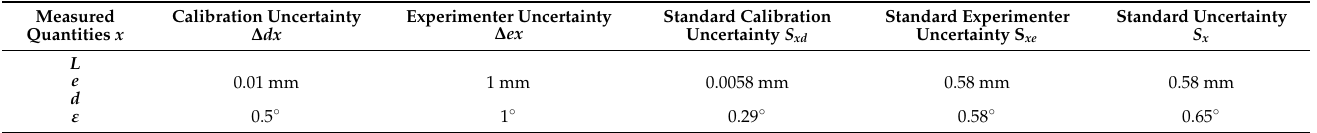
Table 2. Measuring uncertainties of the mechanical control geometrical